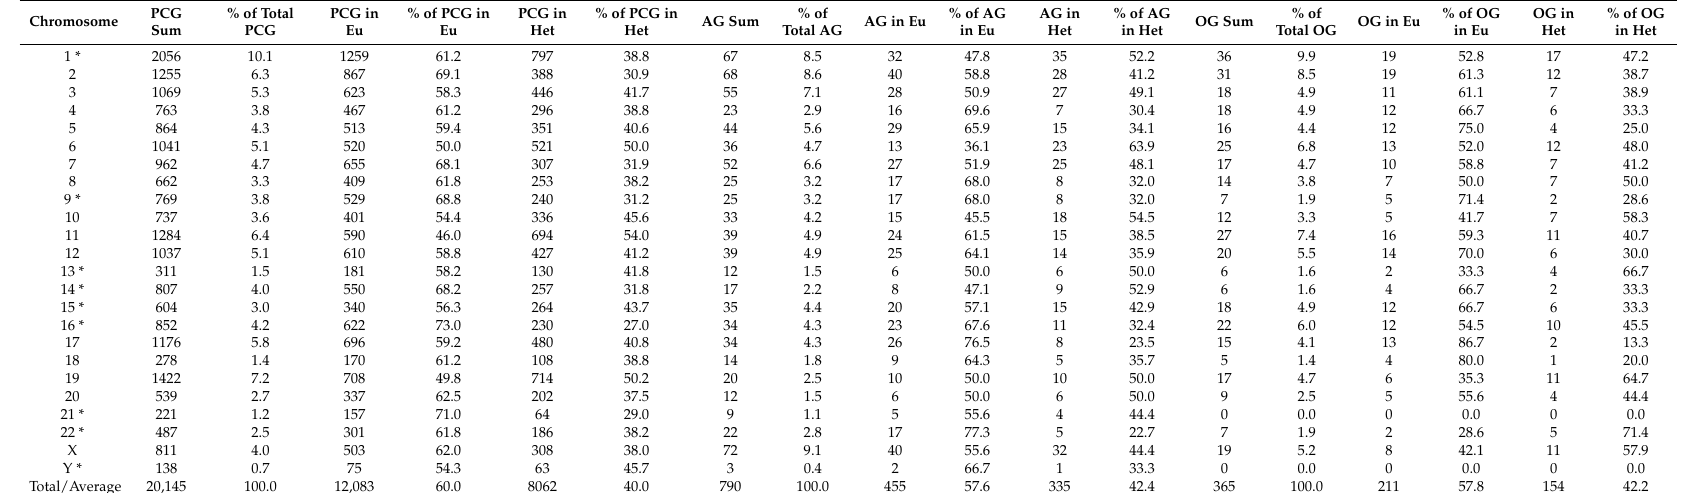
Table 2. Protein coding gene distribution among G-negative euchromatin and G-positive heterochromatin chromosome regions and relationship to autism and obesity